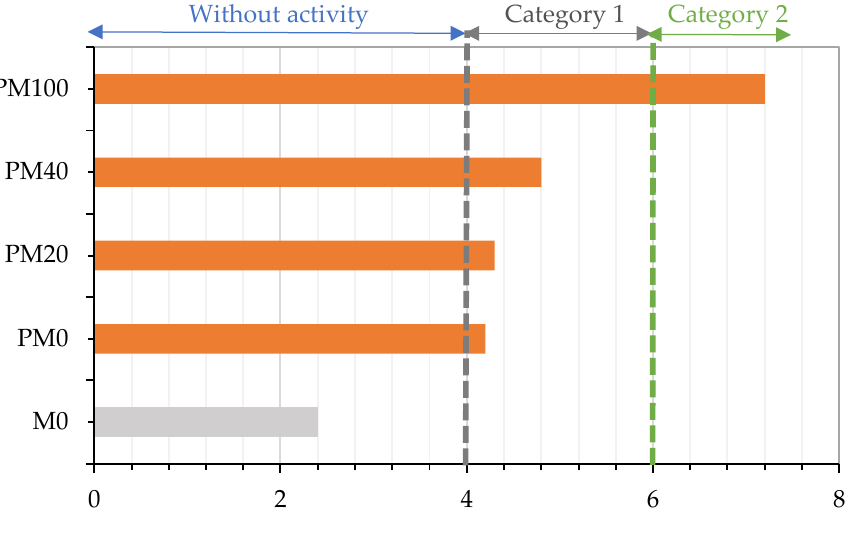
Figure 9. Elimination of NO x (%).